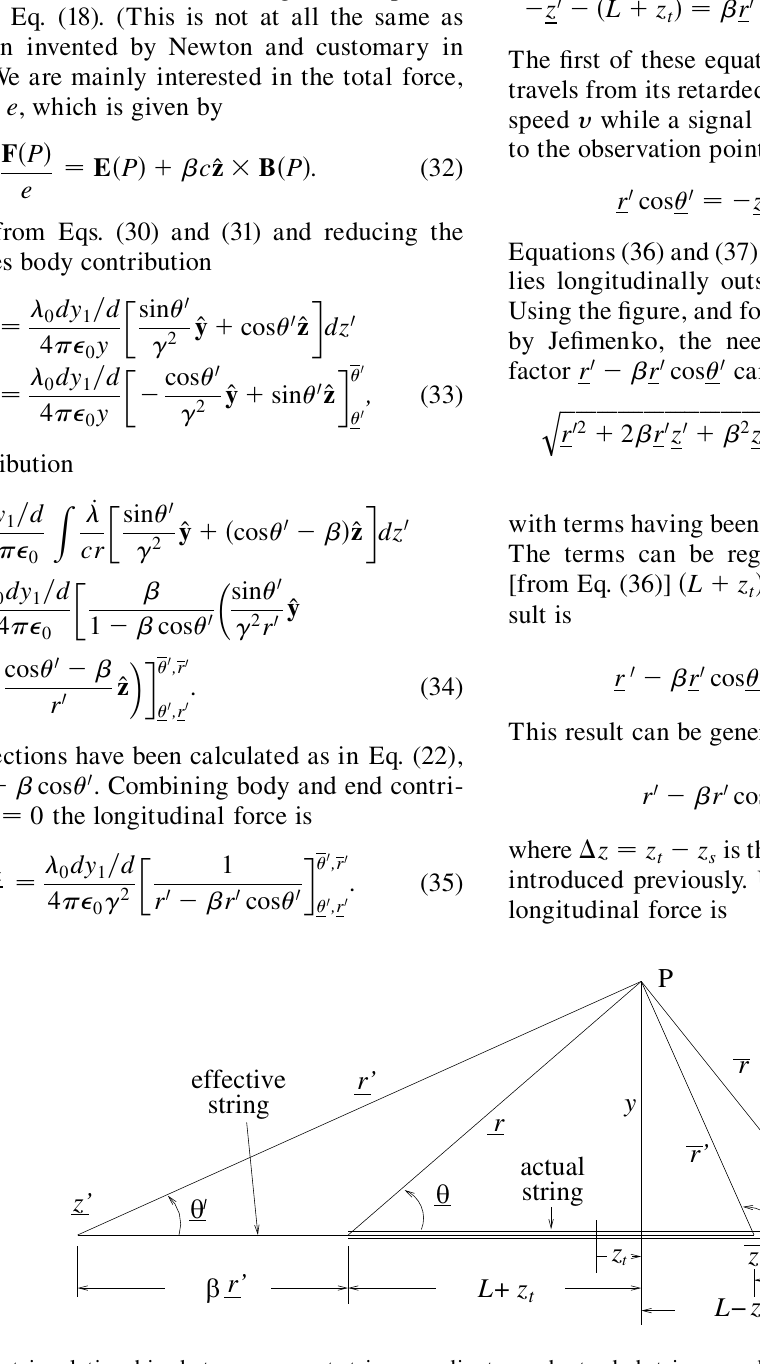
FIG. 5. Geometric relationships between present string coordinates and retarded string coordinates. As drawn z 0 is positive (i.e., to the right of P ) but, for y as large as shown, z 0 would be negative for highly relativistic